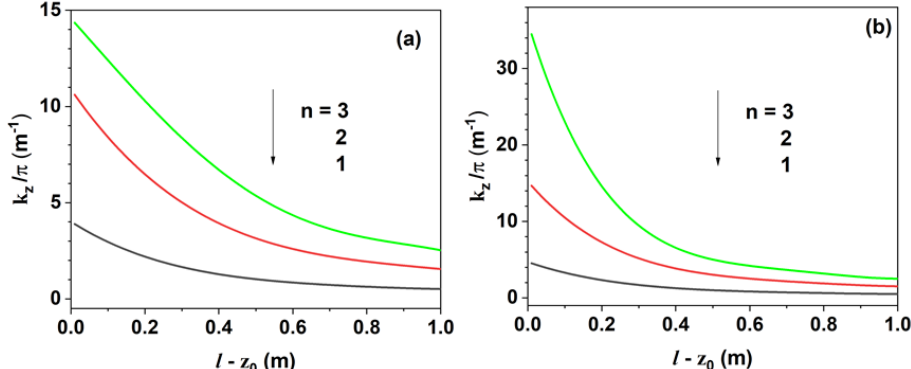
Figure 2. Spectra of three sets of 𝑘 𝑧 values calculated as a function of η ( l − z 0 ): ( a ) r 0 = 0 (𝑥 0𝑖 = 𝑥 0𝑗 = 0, 𝑧 0 = 1 m) and ( b ) r 0 = 0.25 m (𝑥 0𝑖 = 0, 𝑥 0𝑗 = 0.25, 𝑧 0 = 1 m) .